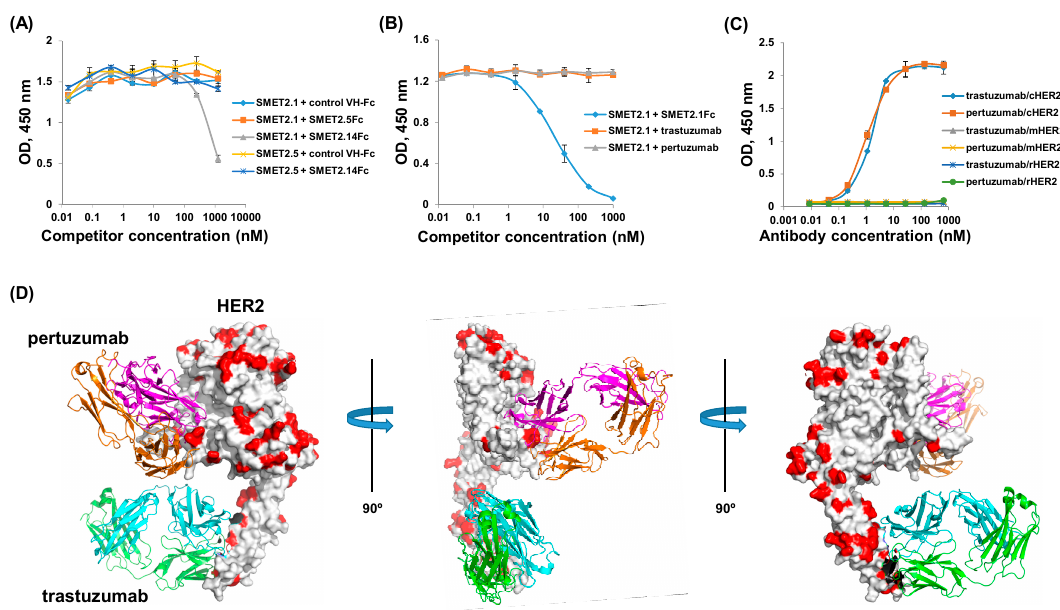
Figure 5. Epitope mapping of SMET2.1. ( A ) Competitive ELISA binding of the anti-HER2 dAbs. The concentrations of dAbs were kept constant (1.5 µ g mL − 1 ). The concentrations of competitors (Fc-fusion proteins) were fivefold serially diluted. Bound dAbs were detected by HRP-conjugated anti-FLAG tag antibody. ( B ) Competitive ELISA binding of SMET2.1 with IgG1 of trastuzumab and pertuzumab. The concentration of SMET2.1 was kept constant (2 µ g mL − 1 ). The concentrations of competitors (IgG1s or Fc-fusion proteins) were fivefold serially diluted. Bound SMET2.1 was detected by HRP-conjugated anti-FLAG tag antibody. ( C ) ELISA binding of trastuzumab and pertuzumab IgG1s to recombinant HER2 proteins from different species. Recombinant HER2 proteins were coated on 96-well plates at a concentration of 2 µ g mL − 1 . Bound IgG1s were detected by HRP-conjugated goat anti-human IgG (Fc-specific) antibody. All the ELISA assays were performed in duplicate. Results are the mean ± standard deviation. ( D ) Superimposition of the crystal structures of hHER2-trastuzumab and hHER2-pertuzumab complexes. Variable amino acid residues of HER2 among mice, rats, cynomolgus monkeys, and humans are indicated in red.